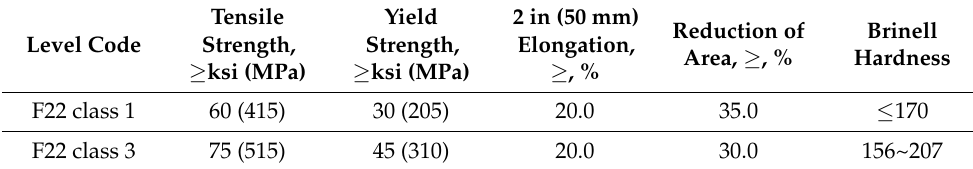
Table 2. F22 alloy material parameters.